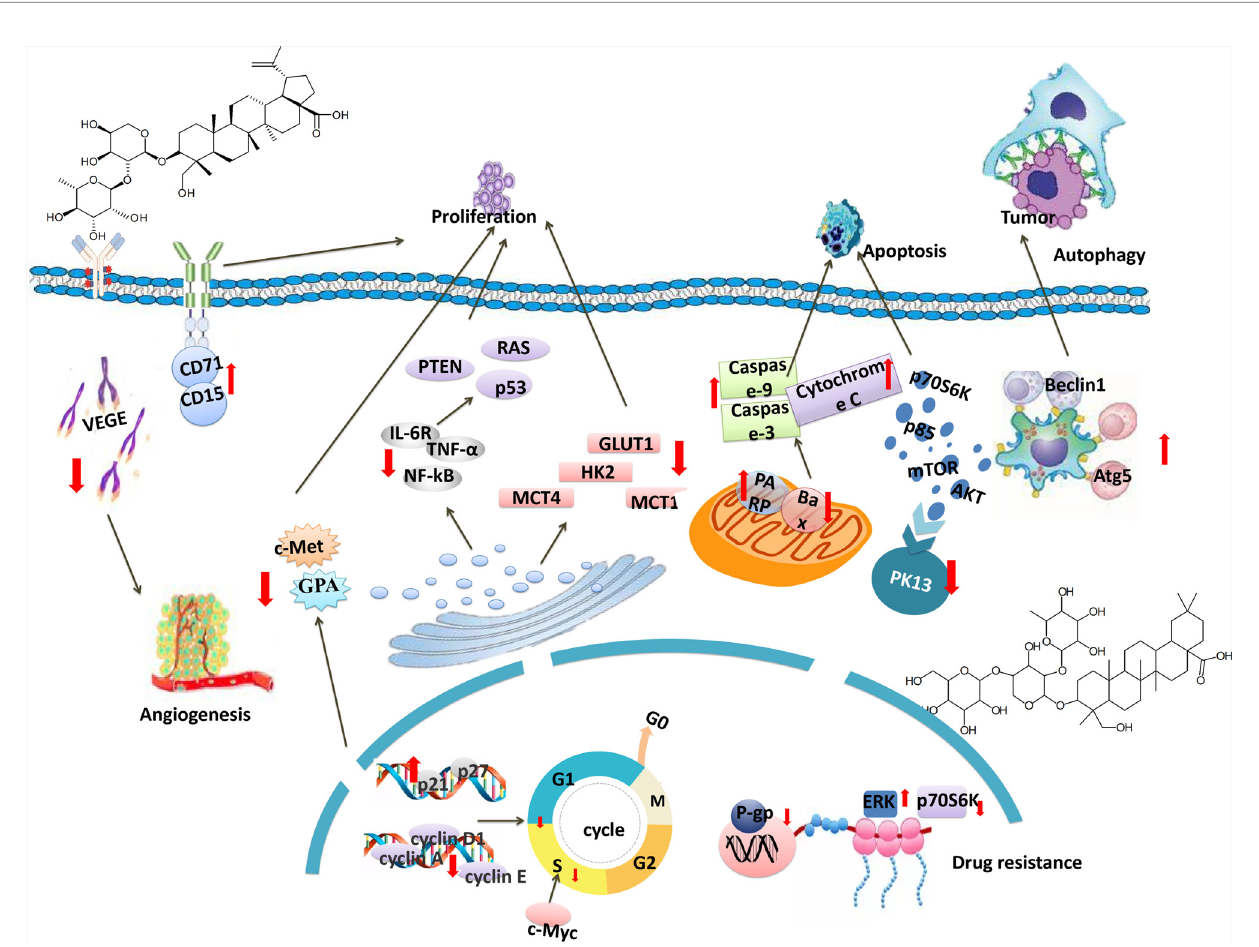
FIGURE 2 | Molecular mechanism of Plusatilla chinensis (Bge.)